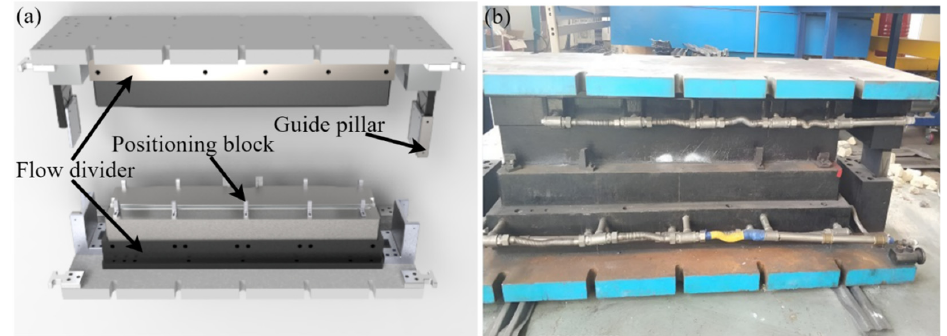
Figure 5. The toolset used for hot stamping tests. ( a ) 3D model. ( b ) Actual